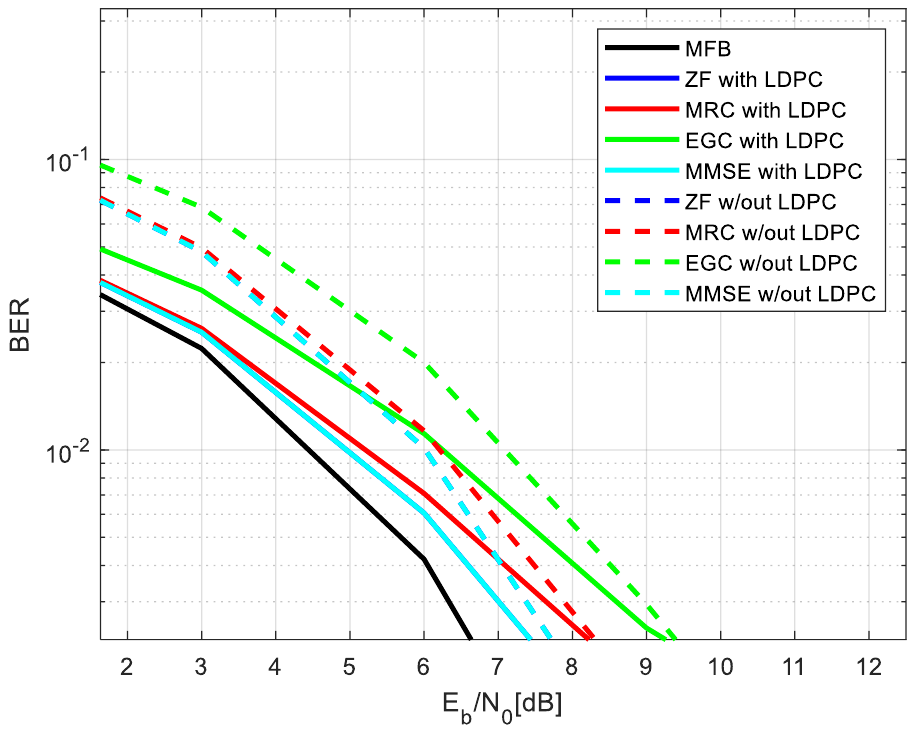
Figure 9. Results for 4X225 LIS System, with 5 users, with and without LDPC codes.